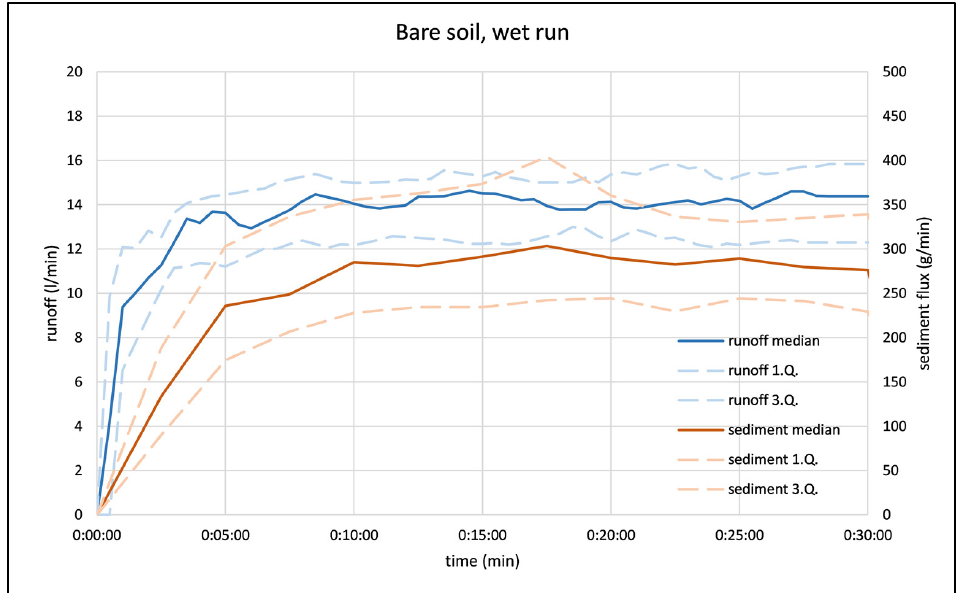
Figure 4. Simulation run under wet soil conditions.